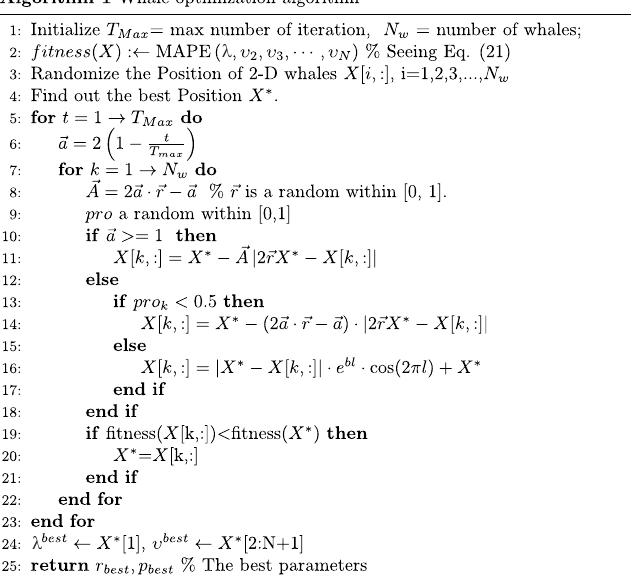
Figure 1. The pseudocode of